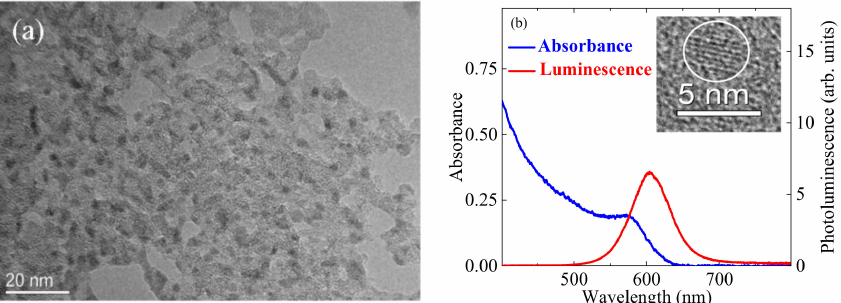
Figure 1. ( a ) TEM image of InP@ZnS QDs. ( b ) Absorption (blue curve) and photoluminescence (red curve) spectra of InP@ZnS CQDs. The absorption spectrum of InP@ZnS shows first excitonic peak at ~575 nm. The emission band excited by 400 nm radiation was centered at 607 nm, with full width at half-maximum of 70 nm. Inset: High resolution TEM image of